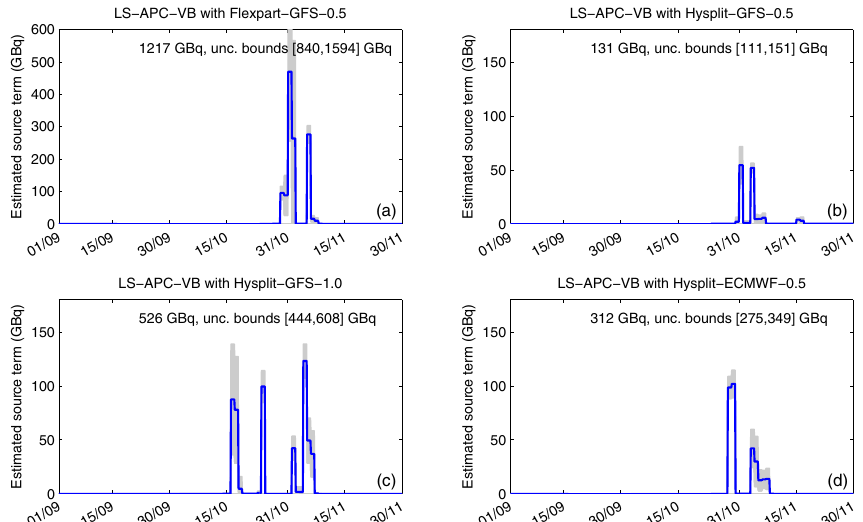
Figure 9. Estimated source terms at locations selected by the marginal likelihood method, shown in Fig. 8, with excluded measurements from Budapest using the LS-APC-VB algorithm for all four tested combinations of dispersion models and meteorological data: Flexpart- GFS-0.5 (a) , Hysplit-GFS-0.5 (b) , Hysplit-GFS-1.0 (c) , and Hysplit-ECMWF-0.5 (d) . The estimated source terms are accompanied by the 95% uncertainty regions (gray filled regions). The estimated activity for the whole period is reported inside each plot with its associated uncertainty bounds.